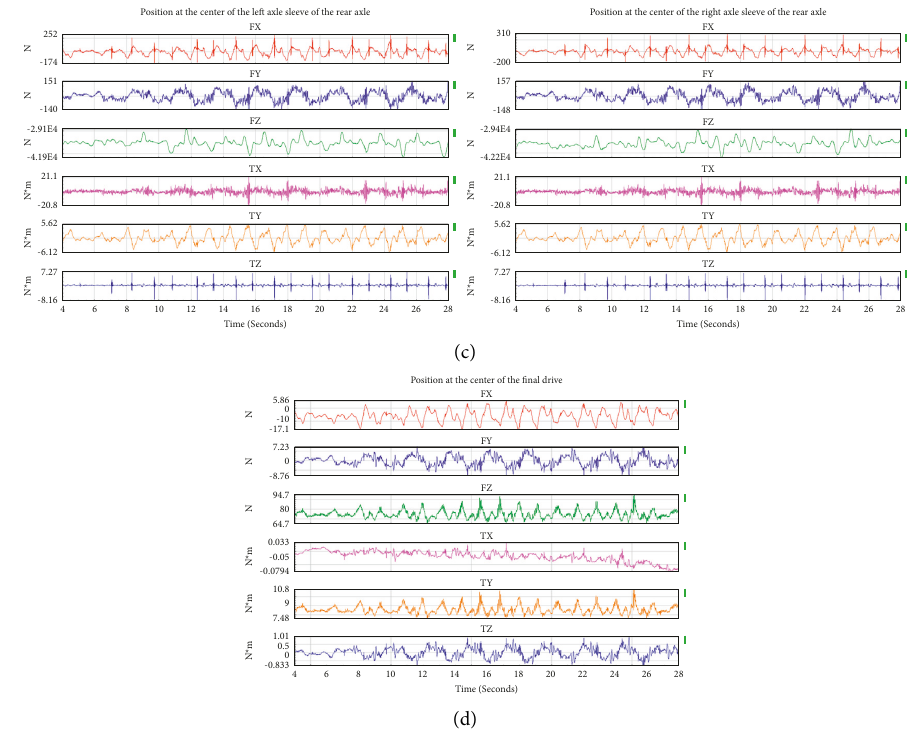
Figure 11: Load spectra of key points of (twisted road). (a) Positions at the centers of the left and right spring seats of the rear axle. (b) Positions at the connection points between the left and right shock absorbers and the shock absorber mounting seats. (c) Positions at the centers of the left and right axle sleeves of the rear axle. (d) Position at the center of the final drive.